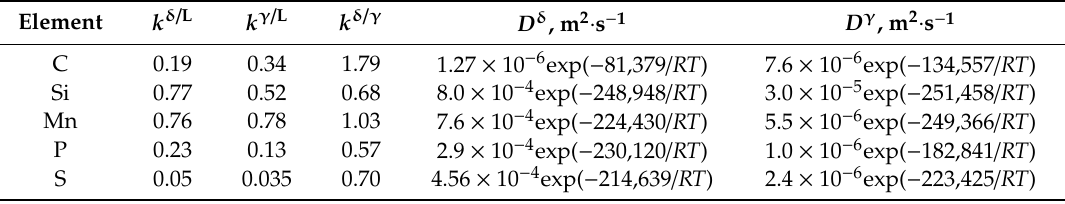
/ 2 is calculated with a solidification / 2 | is calculated last.